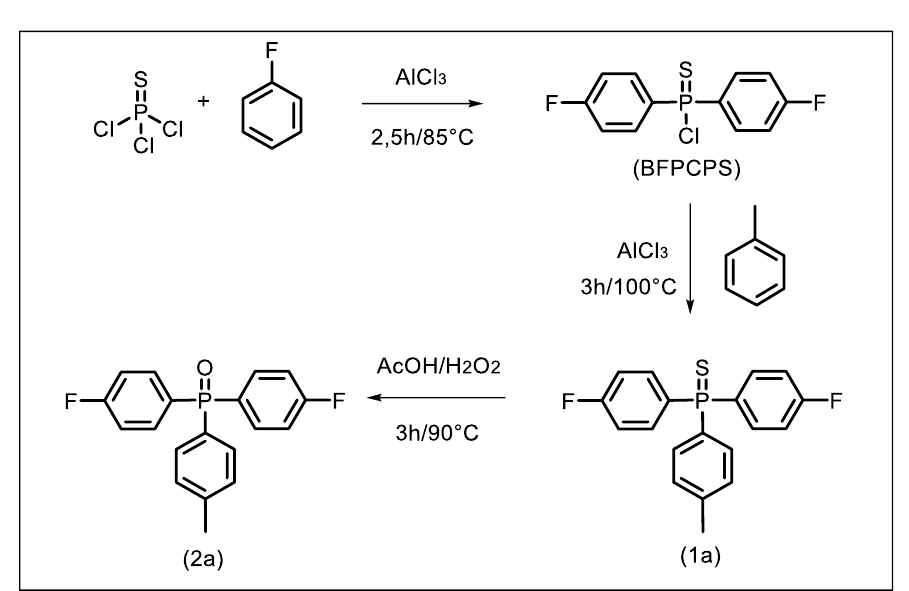
Figure 1. Different steps for the synthesis of the monomers. Figure 1. Di ff erent steps for the synthesis of the